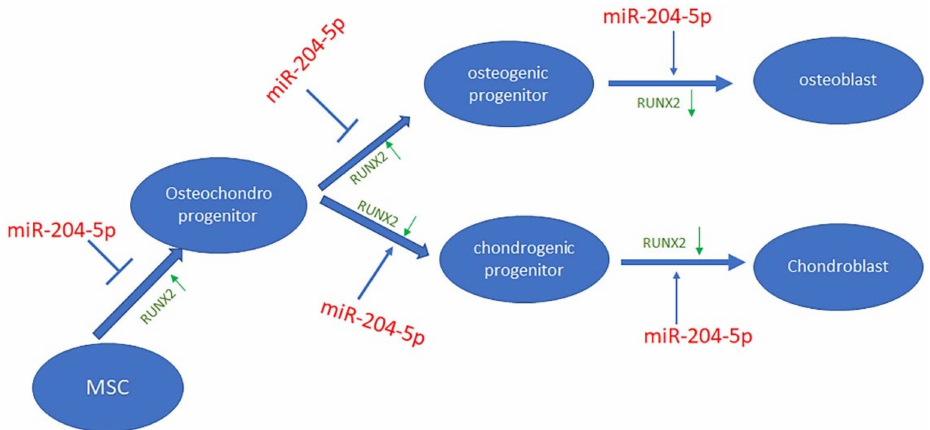
Figure 7. Mechanism of action of miR-204-5p during the commitment and the differentiation phases of MSCs towards chondrogenesis or osteogenesis. miR-204-5p reduces MSCs’ commitment to the osteochondrogenic lineage and promotes the maturation of osteoblasts and chondroblasts by modulating the RUNX2 expression. The expression levels of RUNX2 during differentiation are shown in